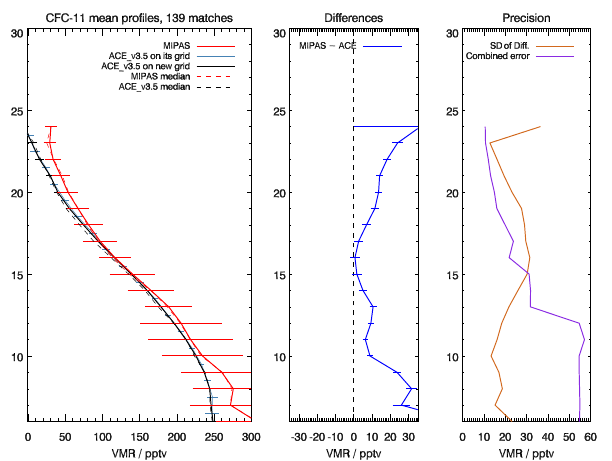
Figure 15. Comparison of mean profiles of MIPAS CFC-11 (left panel, continuous red line) and ILAS-II (left panel: blue line denotes ILAS-II on native grid; continuous black line denotes ILAS-II) for the FR period, corresponding to the MIPAS V5H_CFC-11_20 data set. The dashed lines show the median of each data set. The error bars include the total error for both instruments. The middle panel shows the mean difference (blue) of these profiles and the standard error of the mean. The right panel shows the combined error (pur- ple) of the instruments and the standard deviation of the differences